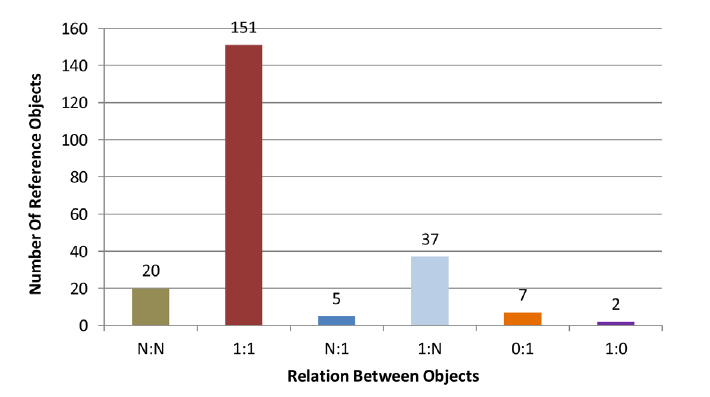
Fig. 20. Extracted relations from the program